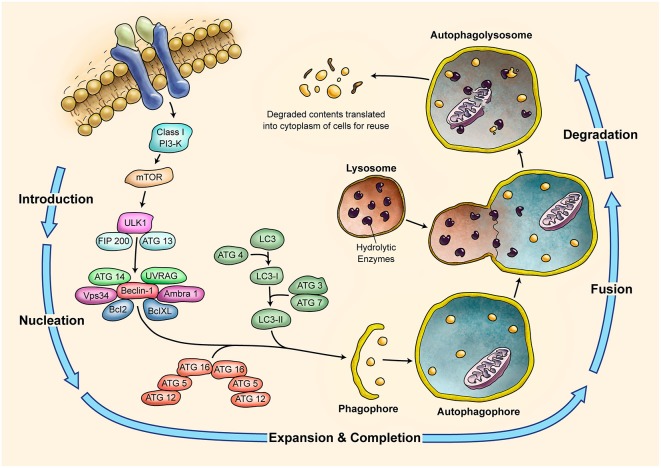
Schematic Representation of Autophagy Pathway. Autophagy is recognized as a major tool to degrade damaged organelles and misfolded proteins via lysosomal pathway. Autophagy is an active flux which includes five different steps; introduction or initiation, phagosome nucleation, phagosome expansion and completion, phagosome and lysosme fusion (autophagolysosome formation), and finally degradation. It is a tightly regulated mechanism and several ATG molecules are included in its regulation.